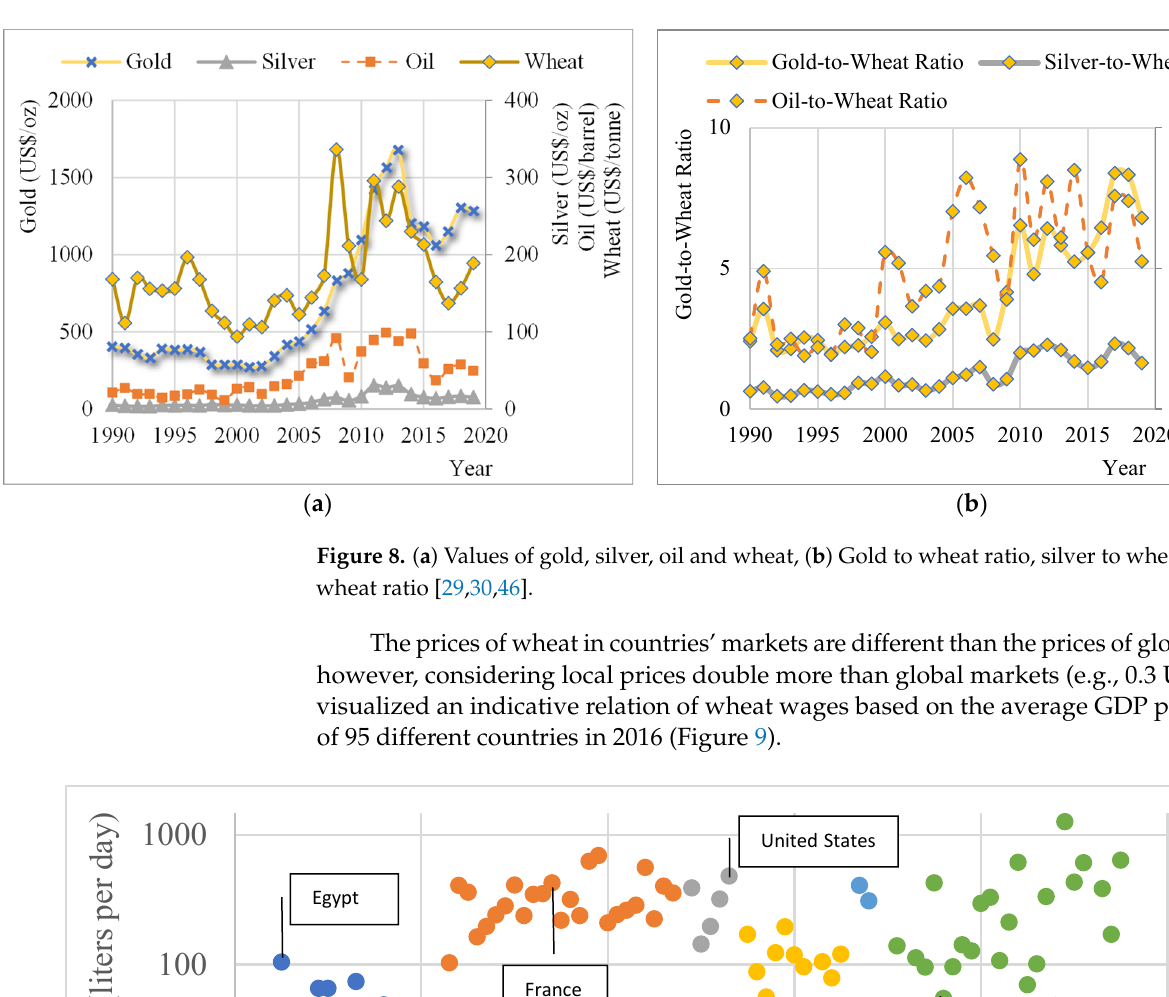
Figure 9. Average wheat wages (2016) related to the average wheat wage of an unskilled laborer in antiquity. Data are presented as an order of magnitude.